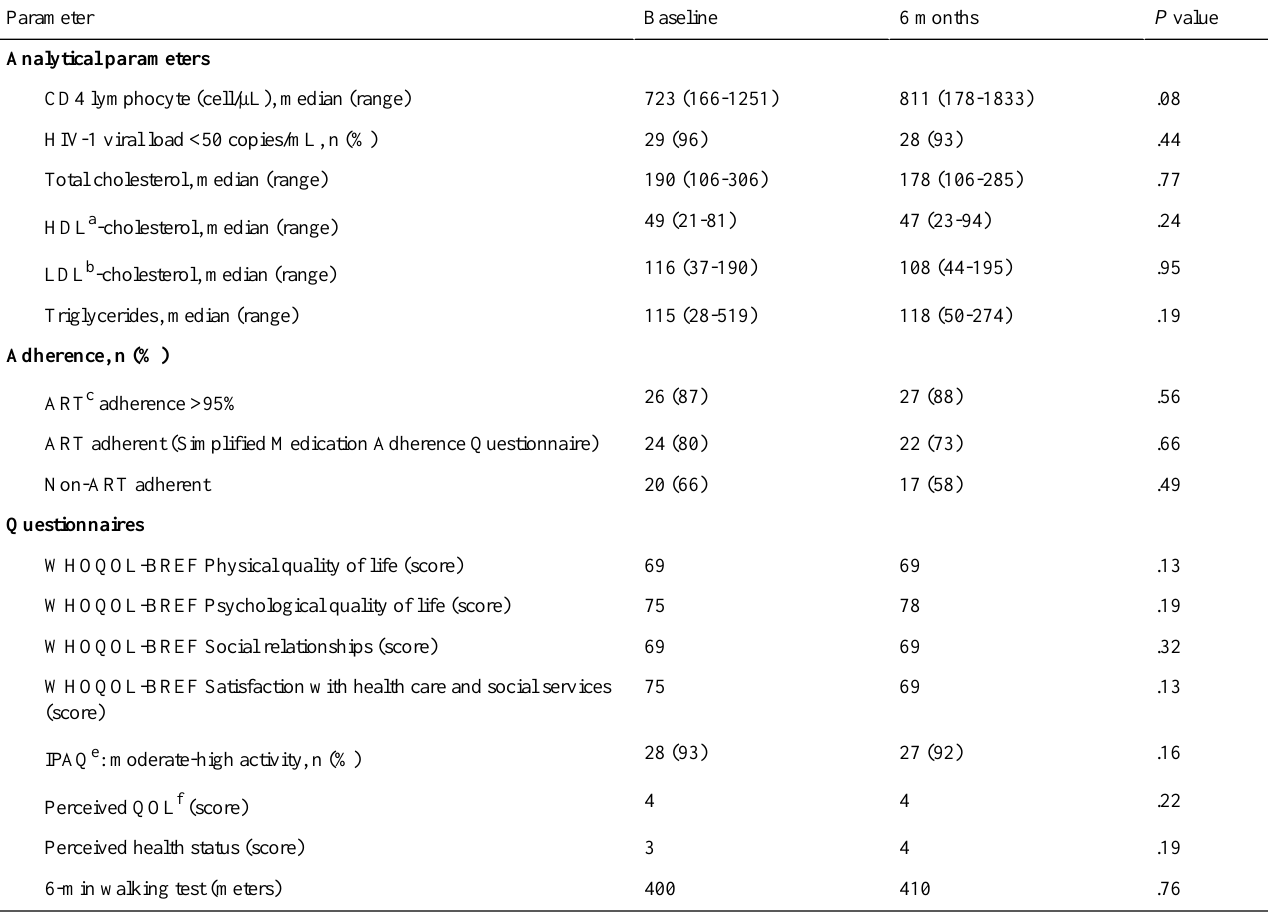
Table 2. Evolution of the main parameters